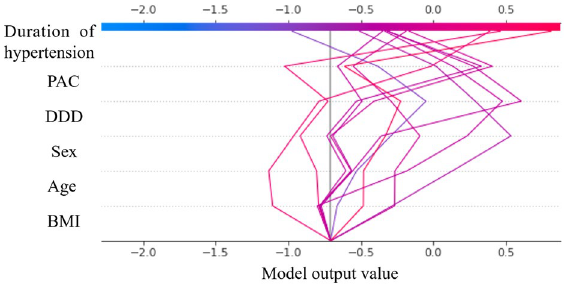
Figure 5. SHAP decision plot of patients misclassified in the developed model. The vertical axis of the decision plot showed each feature of the predictive model. The colored prediction lines started at the bottom of the plot and show how the SHAP values accumulate from the base value to arrive at the model’s final score at the top of the plot. The prediction lines tended to make drastic turns at feature with high importance and reached the estimated probability of complete clinical